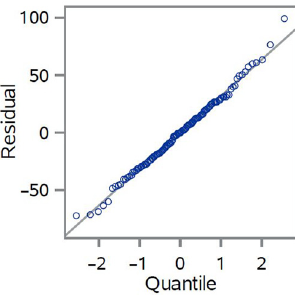
Figure 7. AMC Cann